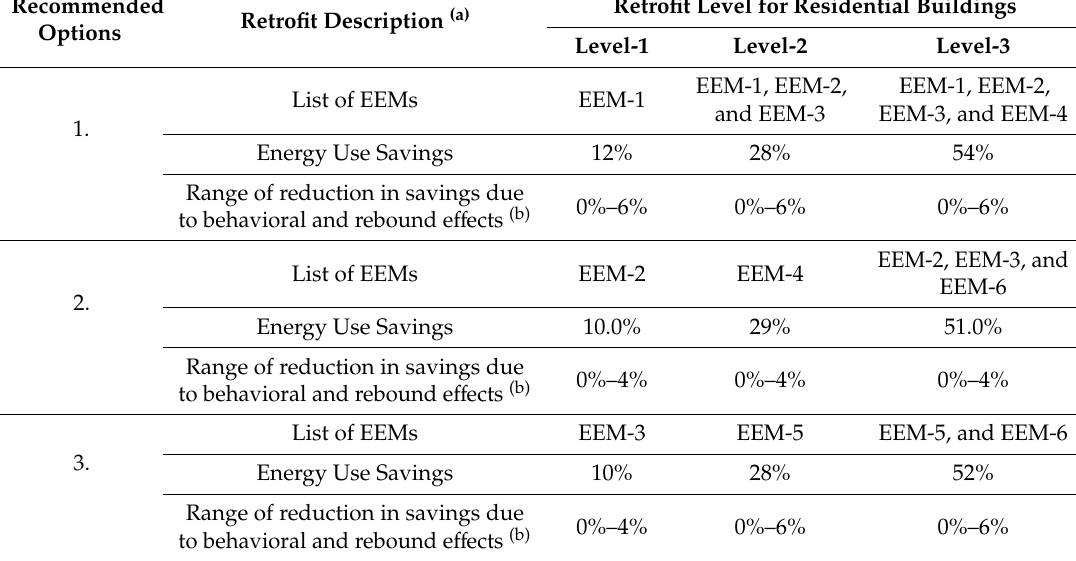
Table 22. Options for energy e ffi ciency measures specific to three retrofit levels of Omani residential buildings (source: